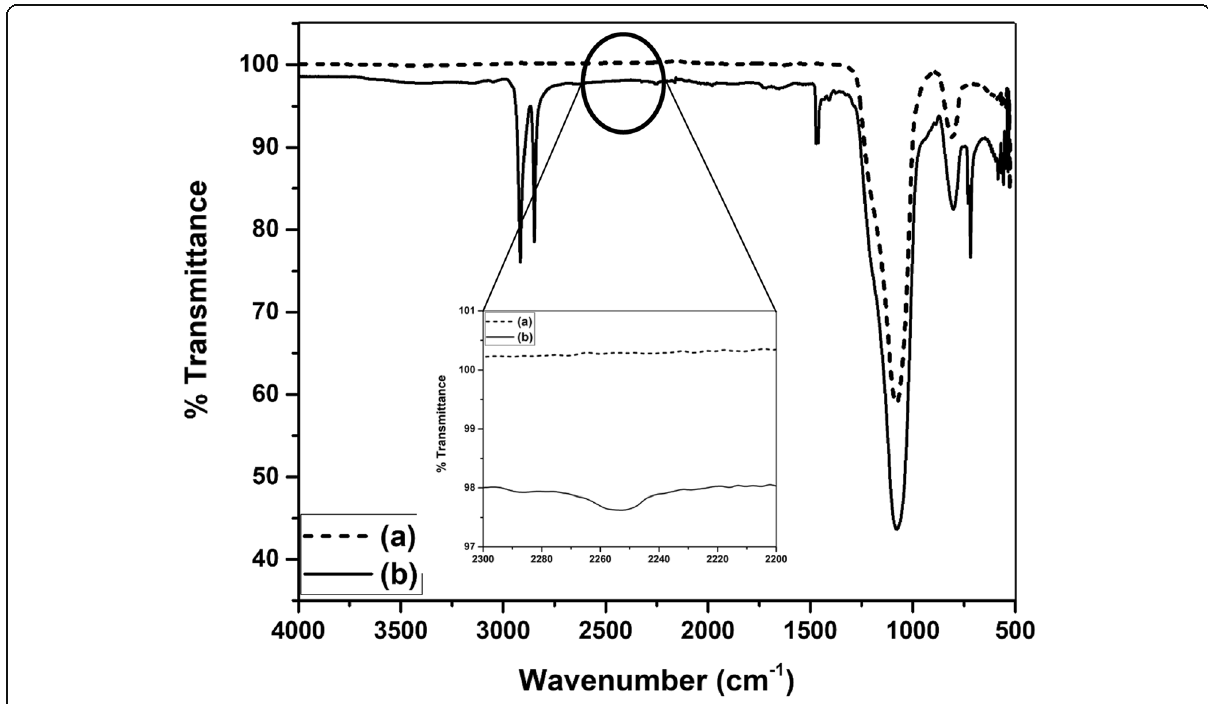
Fig. 4 FTIR spectra of FSNPs ( a ) and CN-FSNPs ( b